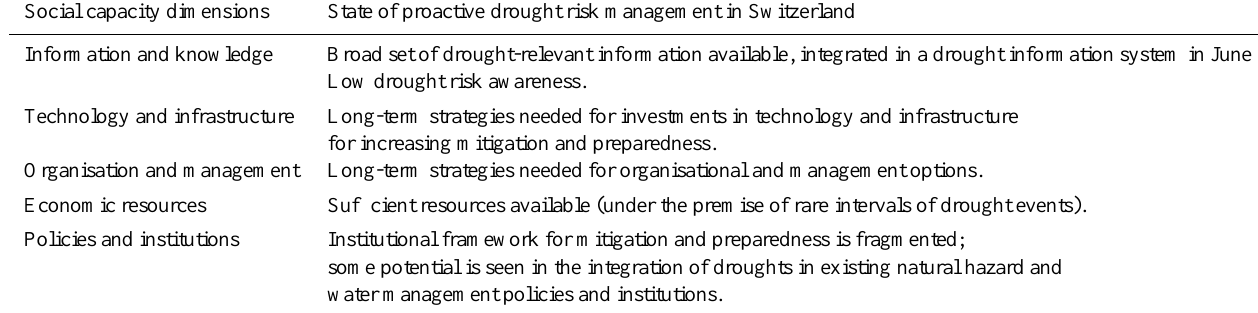
Table 4. State of social capacities for proactive drought risk management in Switzerland. Social capacity